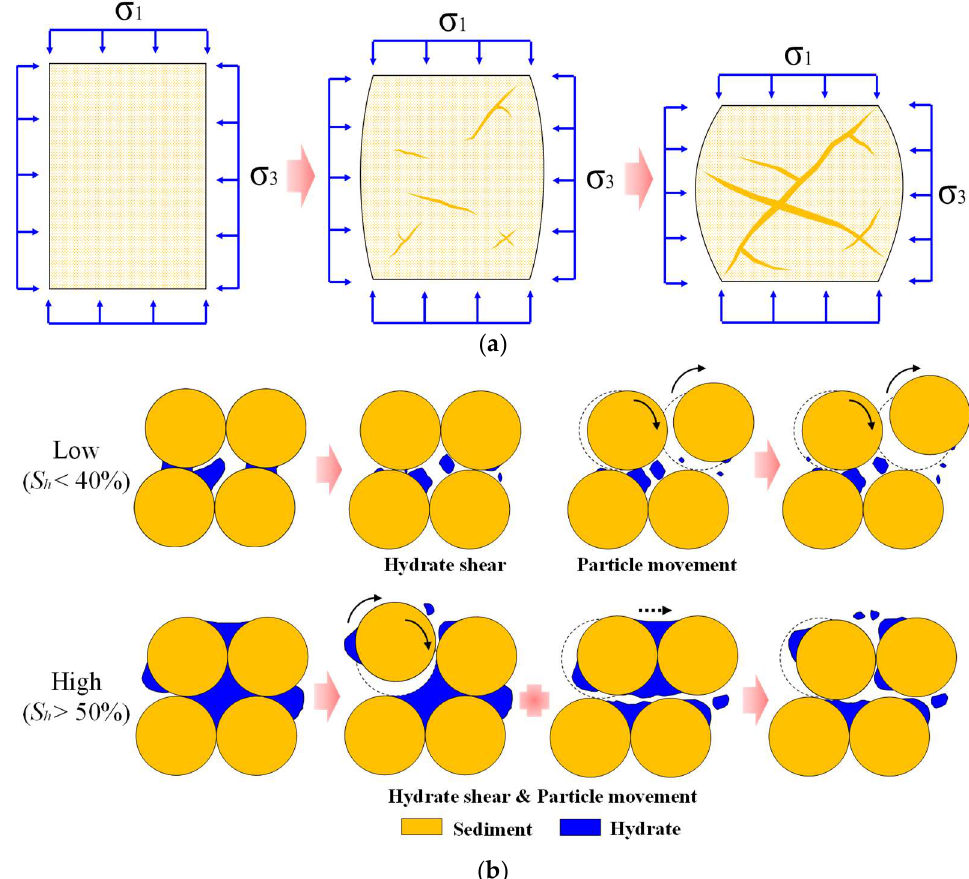
Figure 9. Failure mechanism of HBS: ( a ) Triaxial shearing process, ( b ) Failure mechanism during the shear process [40,41].